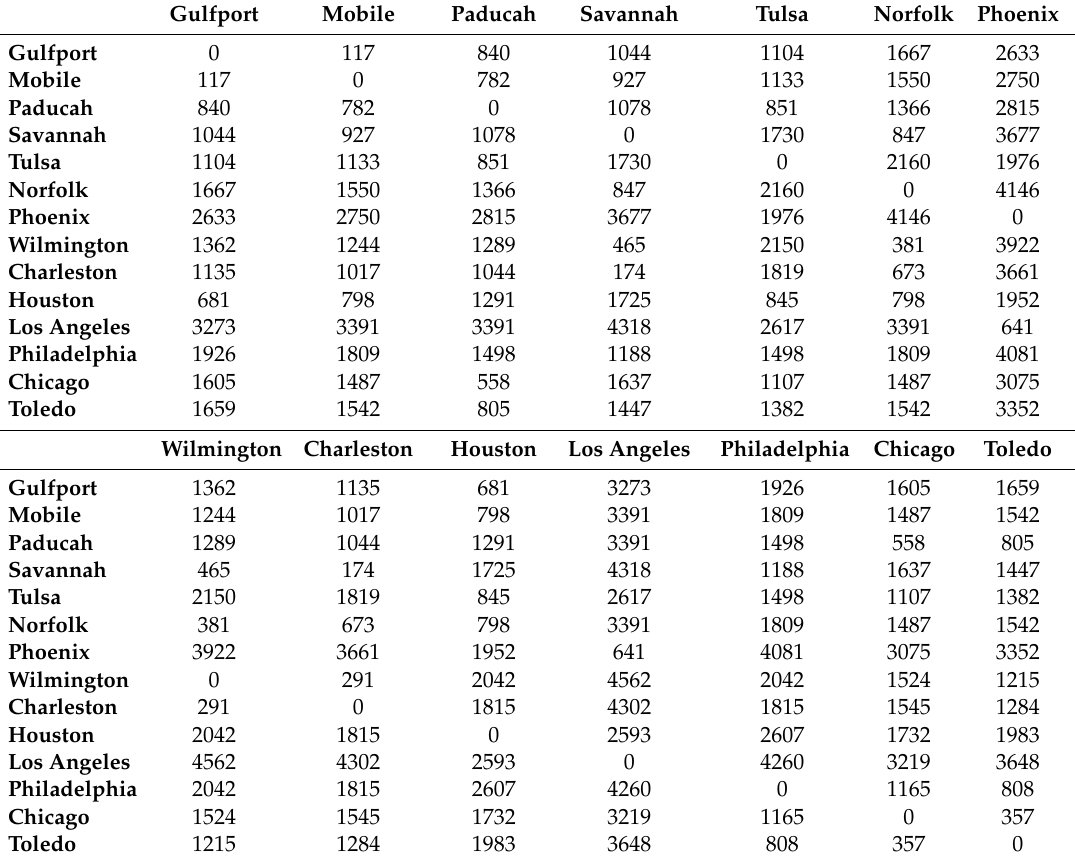
Table A7. Rail distances between Extraction and Transesterification locations (km). Gulfport Mobile